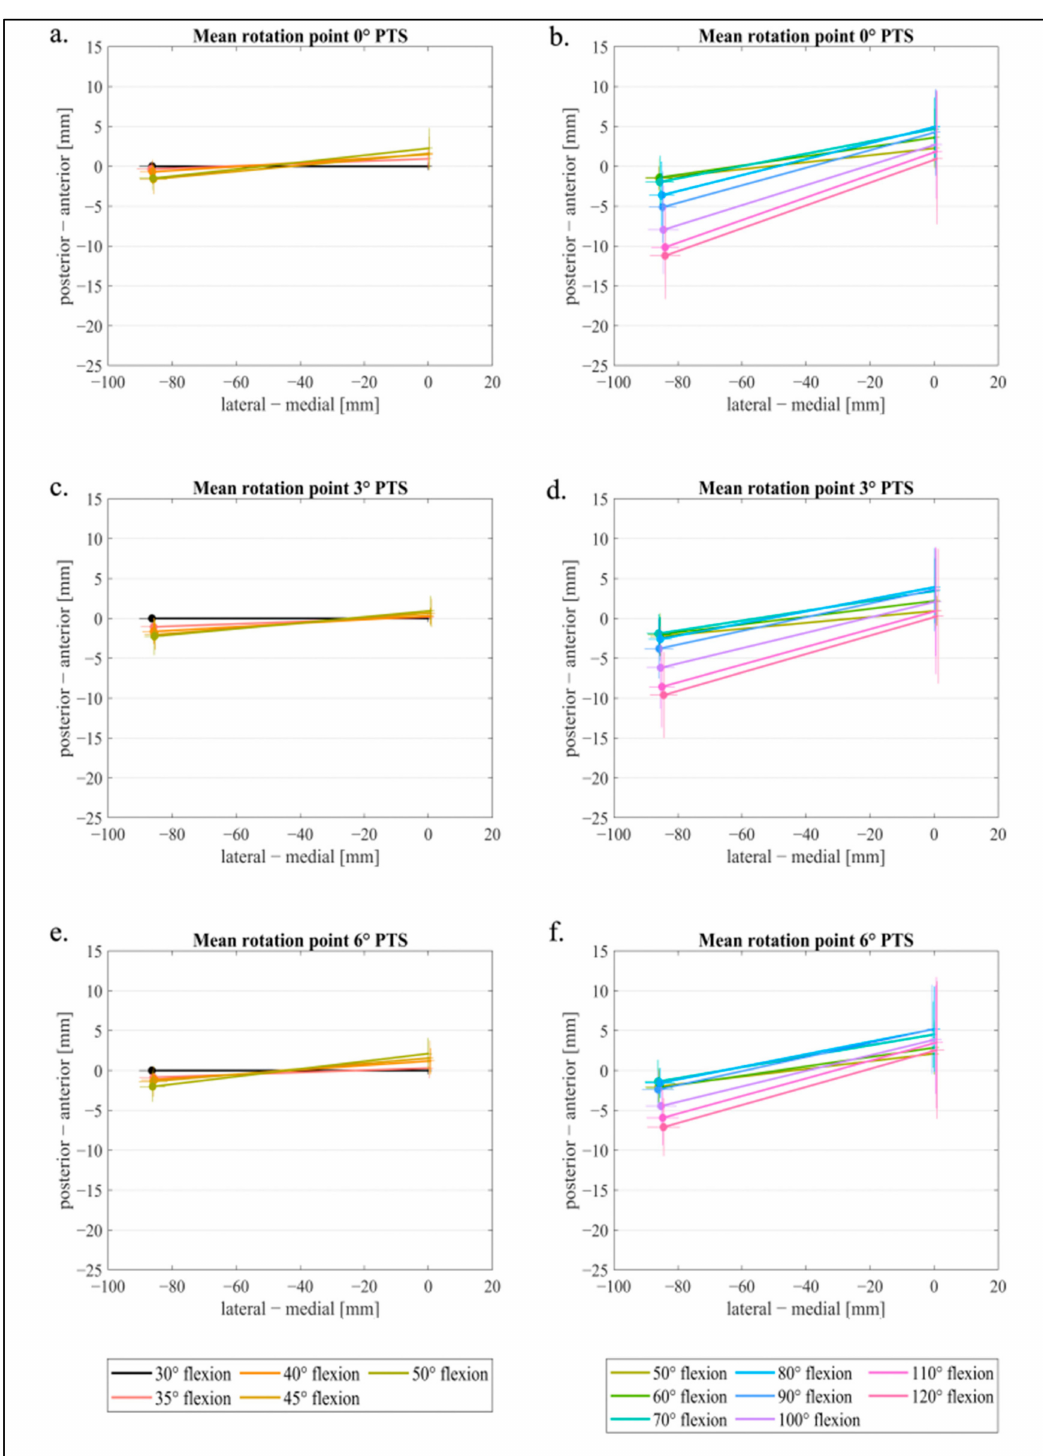
Figure 6. Mean values and vertical/horizontal standard deviation of medial and lateral femoral condyle points for ( a ) 0 ◦ PTS for 30–50 ◦ flexion, ( b ) 0 ◦ PTS for 50–120 ◦ flexion, ( c ) 3 ◦ PTS for 30–50 ◦ flexion, ( d ) 3 ◦ PTS for 50–120 ◦ flexion, ( e ) 6 ◦ PTS for 30–50 ◦ flexion, and ( f ) 6 ◦ PTS for 50–120 ◦